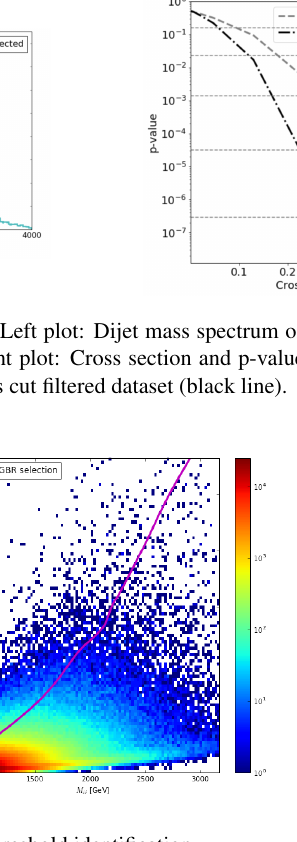
Figure 8. Quantile regression for loss threshold identification.